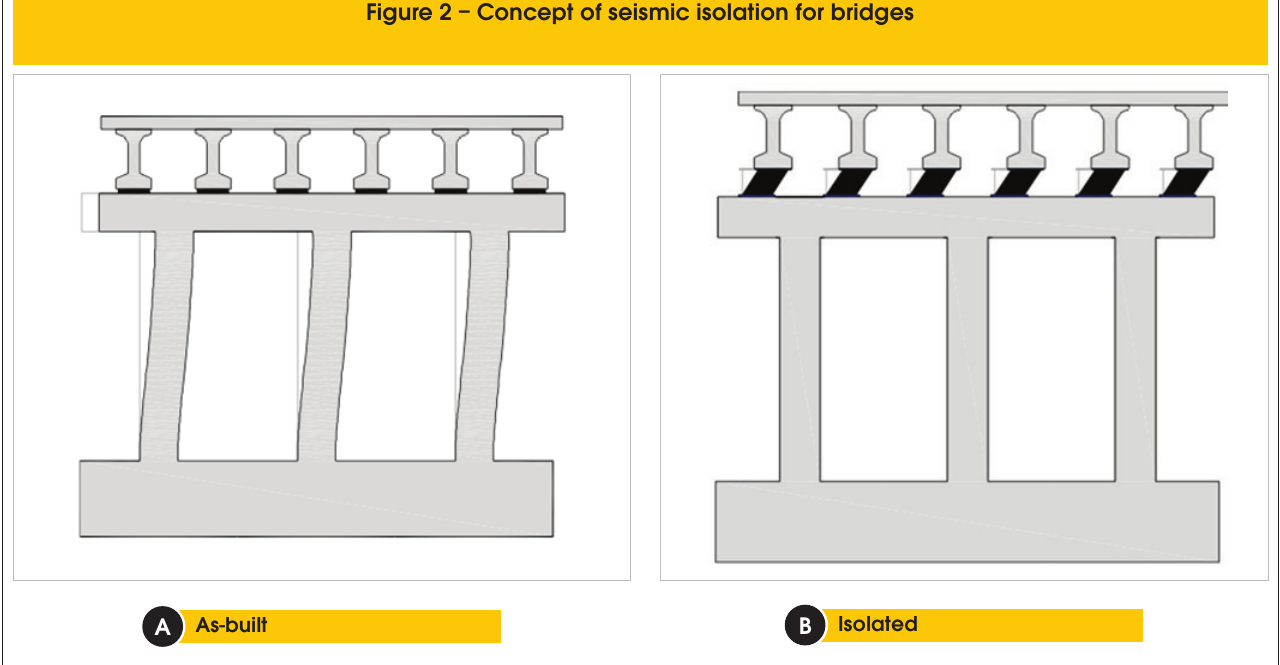
Figure 2 – Concept of seismic isolation for